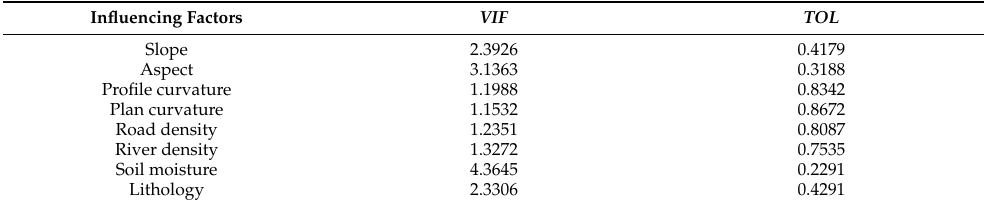
Table 3. Results of multicollinearity test for